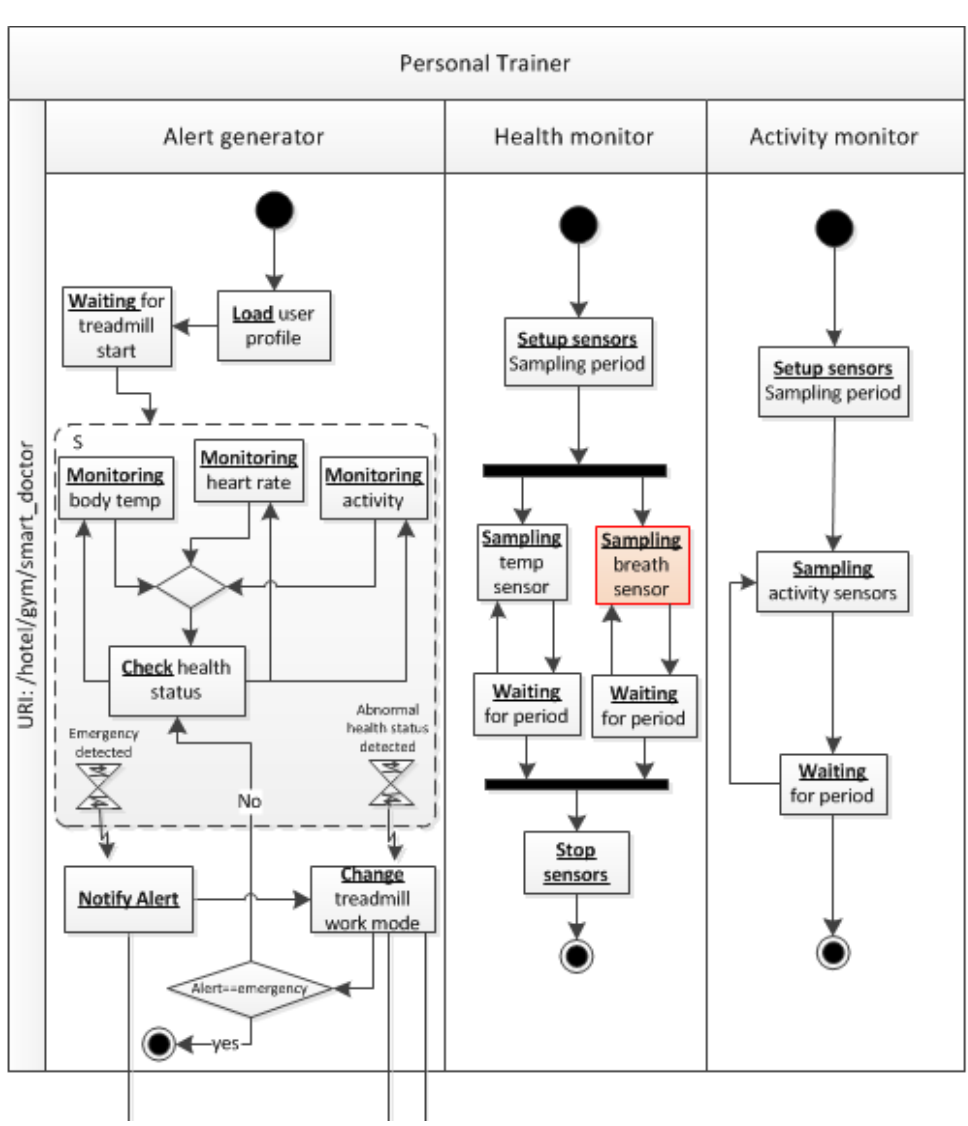
Figure 12. Inconsistent ECM